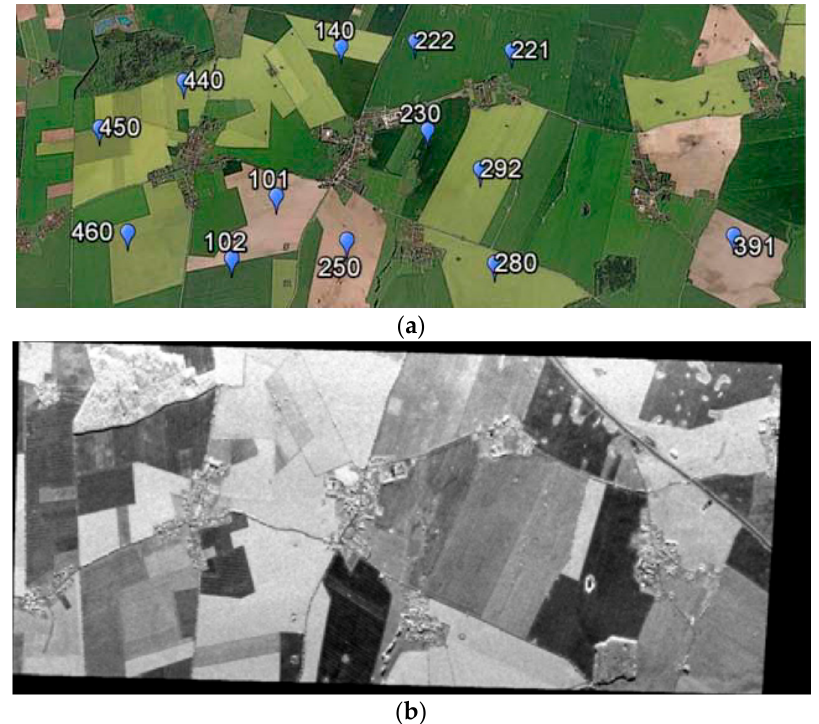
Figure 9. ( a ) Optical image of the Demmin study area, Germany, with indication of in situ measurements. ( b ) E-SAR HH-pol image. North is the top of the image, east is on the right. The area is about 8500 m × 3000 m wide.